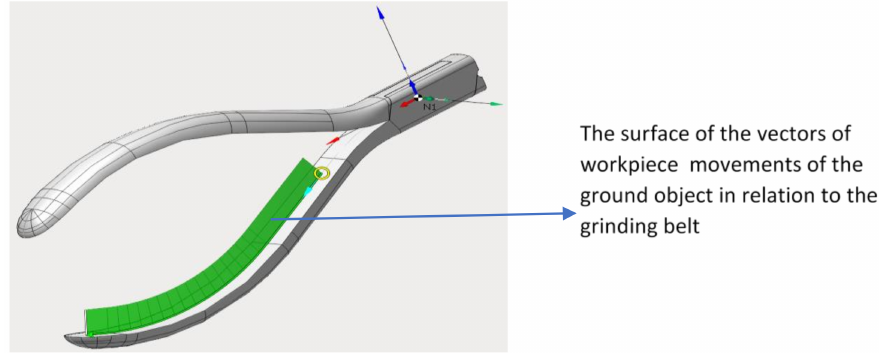
Figure 8. Grinding strategy of the inner surface of the